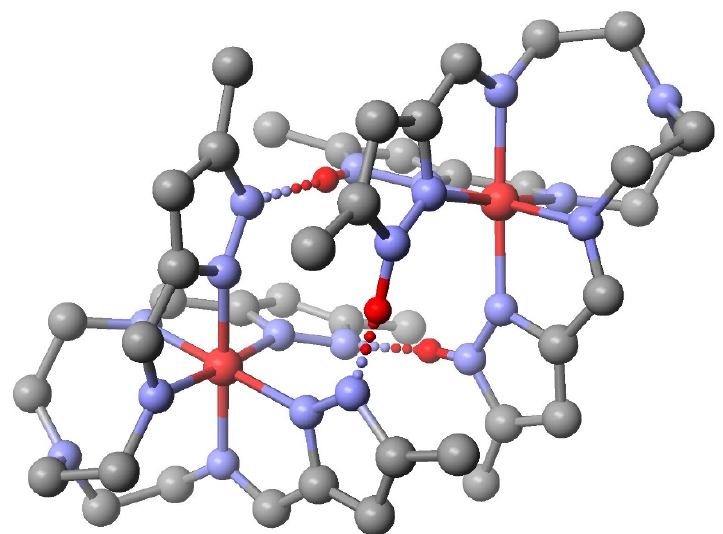
Figure 11. Structure of the {[Fetren(5-MePyrzH) 3 ][Fetren(5-MePyrz) 2 ]} 2+ cation. Hydrogen atoms have been omitted for clarity except for those involved in N pyrazole –H ... N pyrazolate bonding, shown in red. The iron(II) complex (upper right) is SCO. Fe-N imine Fe-N pyrazole , Fe-N ap , N imine –Fe-N pyrazole , and C-N ap –C for iron(II) at 123 K are as follows: 1.9741 Å, 1.9552 Å, 3.446 Å, 79.77°, and 120.0°.